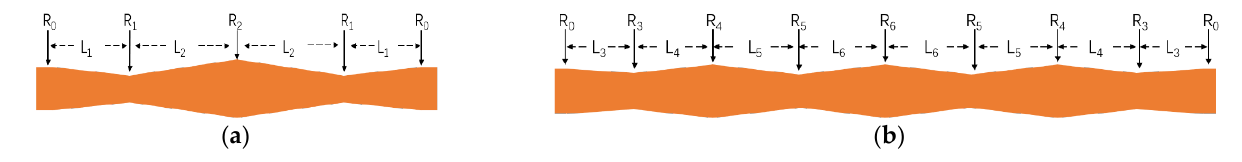
Figure 1. ( a ) Structure of TE 02 -TE 01 mode converter; ( b ) Structure of TE 03 -TE 02 mode